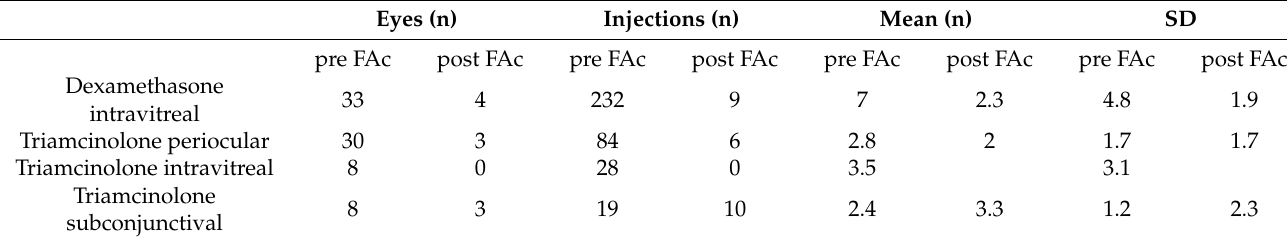
Table 2. Injections pre- and postinjection of the FAc implant.